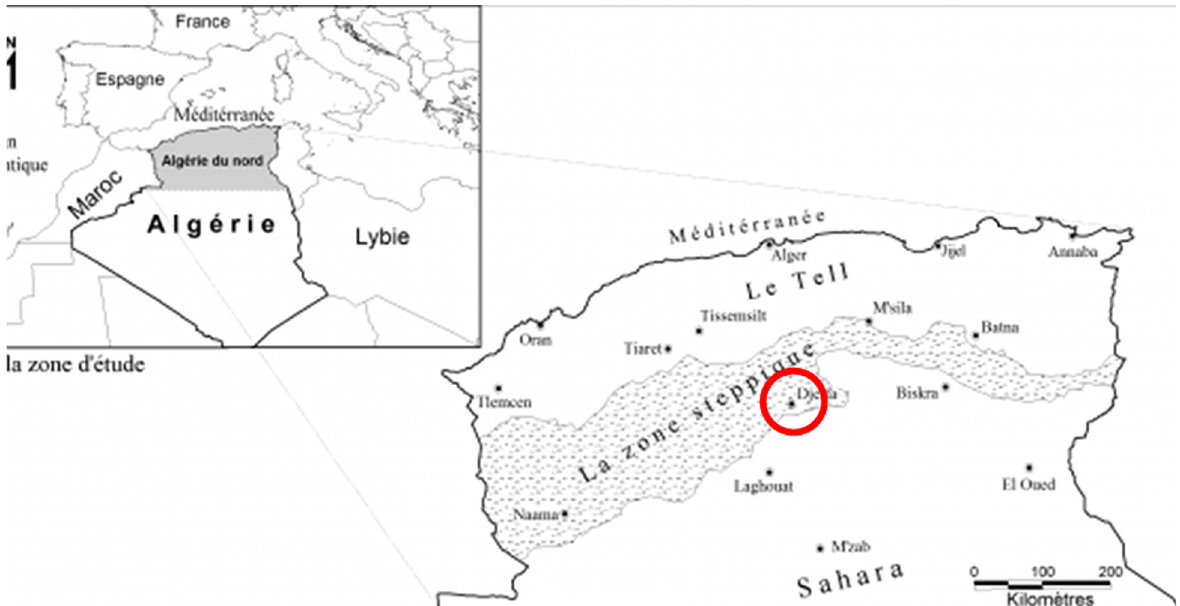
fig. 1. Location of the city of Djelfa on highlands band (Benslimane et al. 2009). Source: own elaboration.